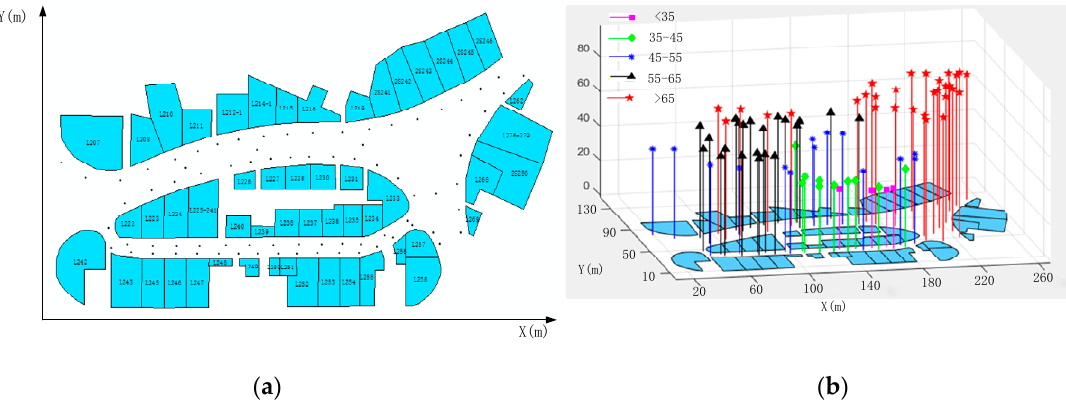
Figure 7. ( a ) Location and ( b ) access points’ (APs’) number distribution of reference points (RPs).